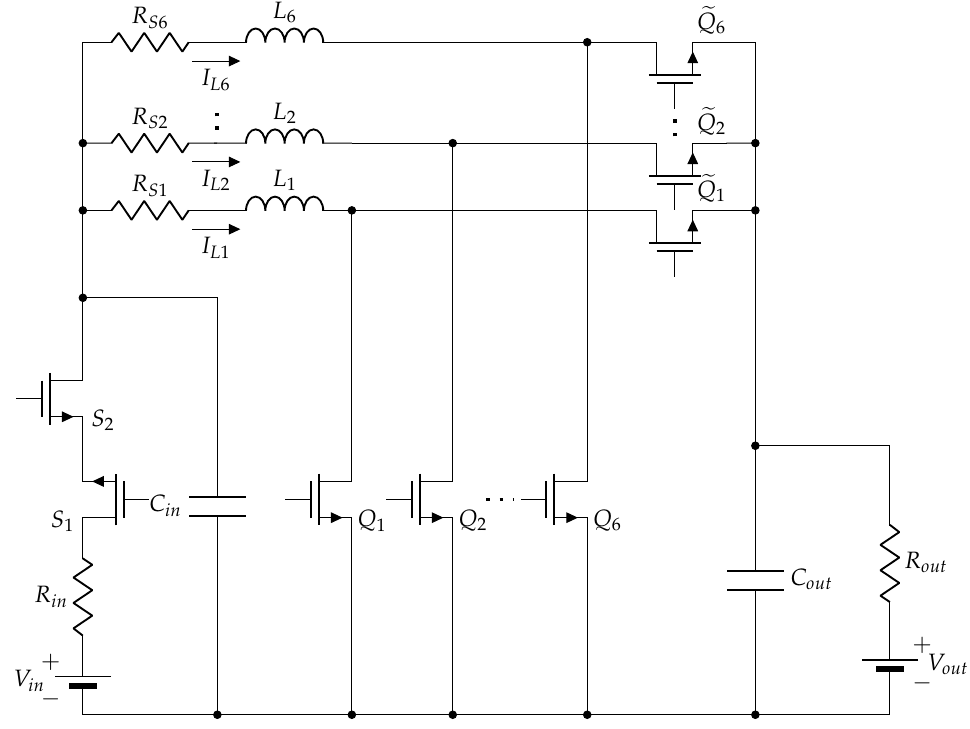
Figure 5. Power stage